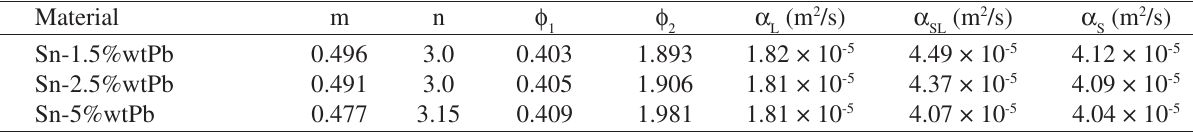
Figure 4. Cellular/Dendritic spacings as a function of cooling rate. Table 1. Values used to calculate cooling rate and tip growth rate. Material